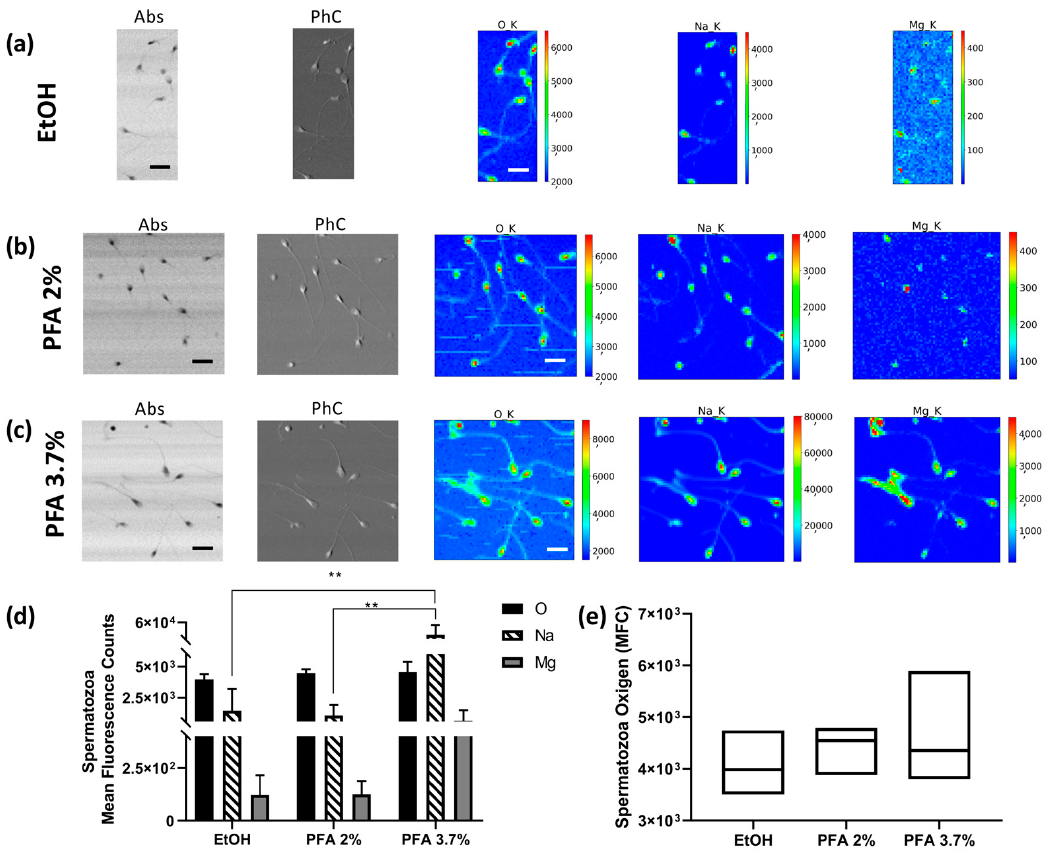
Figure 4. STXM and XRF analysis of human spermatozoa. Absorption (Abs) and phase contrast (PhC) images, together with O, Na and Mg maps of spermatozoa fixed with different methods: ( a ) EtOH 70% (mapped area 30 × 75 μ m 2 ), ( b ) PFA 2% (mapped area 70 × 70 μ m 2 ), and ( c ) PFA 3.7% (mapped area 70 × 70 μ m 2 ). Scale bars are 10 μ m. ( d ) Normalised average XRF counts of O, Na, and Mg in spermatozoa fixed with EtOH 70%, PFA 2%, and 3.7% evaluated on at least 6–10 cells/patient/fixation method. ( e ) Min-to-max box plot comparing oxygen MFC as obtained by